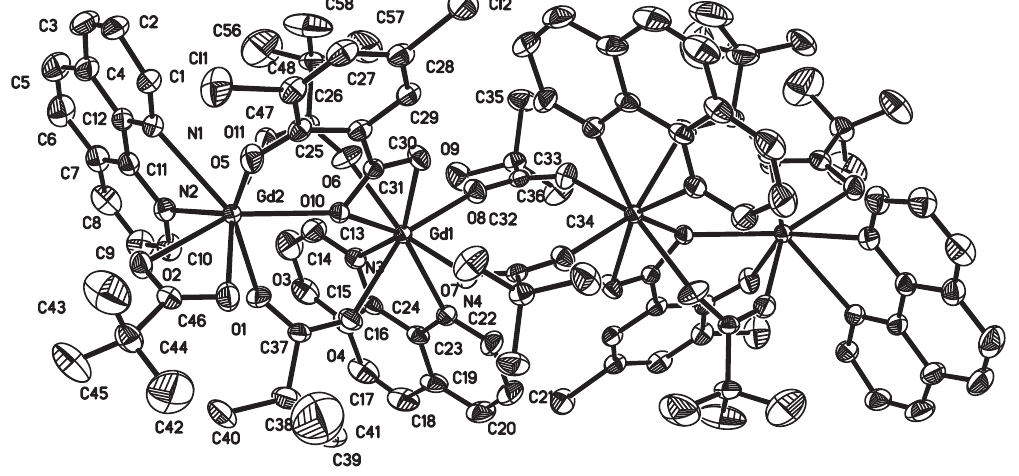
Table 1: Data collection and handling.